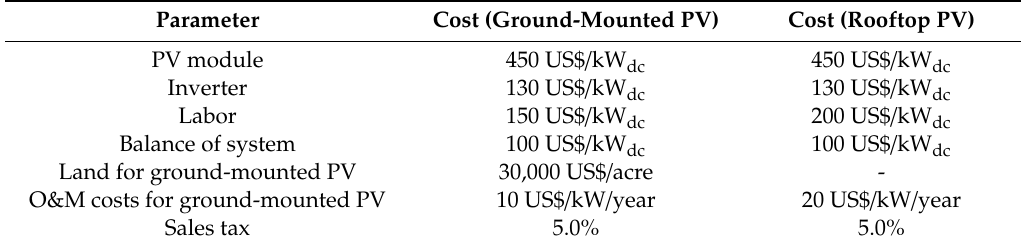
Table 6. Economic parameters of the PV system [44].